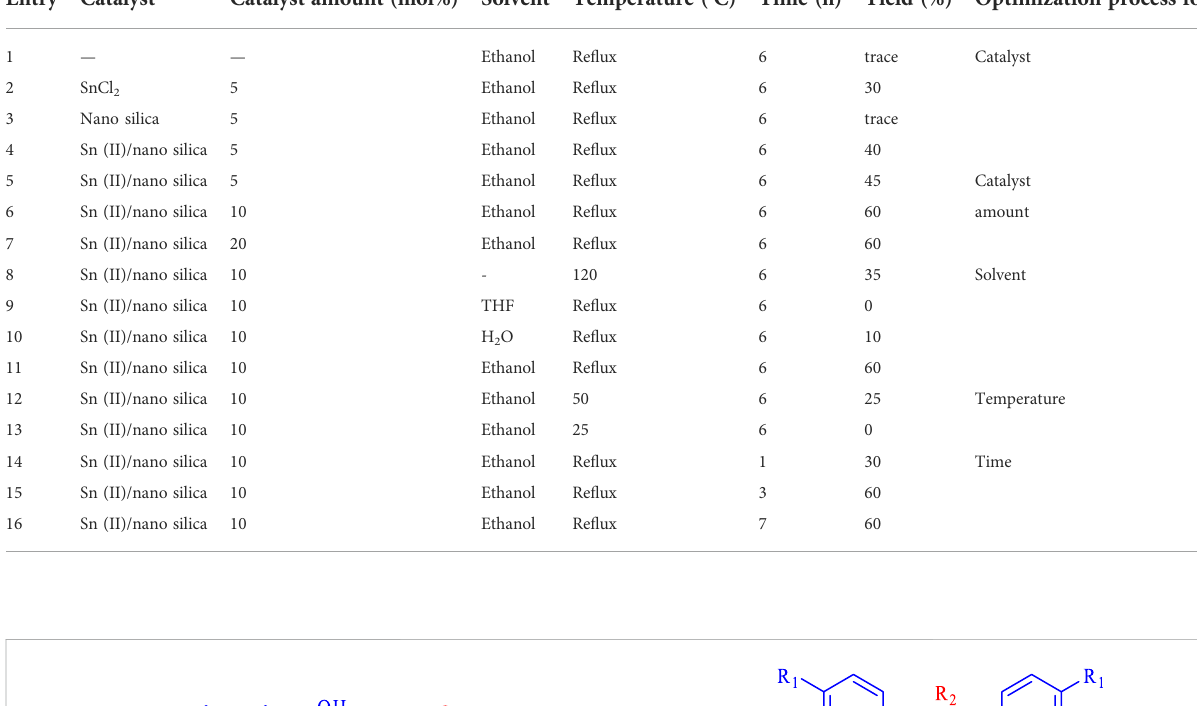
TABLE1Optimizationofthereactionconditionsforthemodelreaction(1 mmolbenzaldehydeand2 mmol β -naphtholin10 mlsolvent).Allyieldsare reported after the separation, puri fi cation, and weighting of the product. Entry